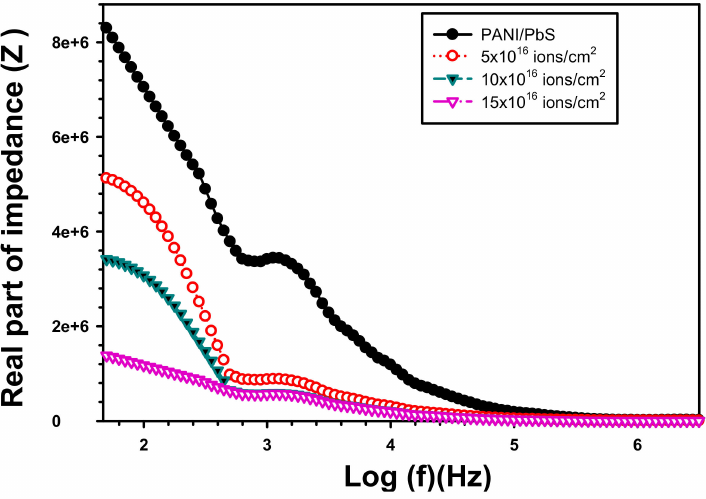
Figure 10. Real impedance Z (cid:48) with frequency for pristine and treated